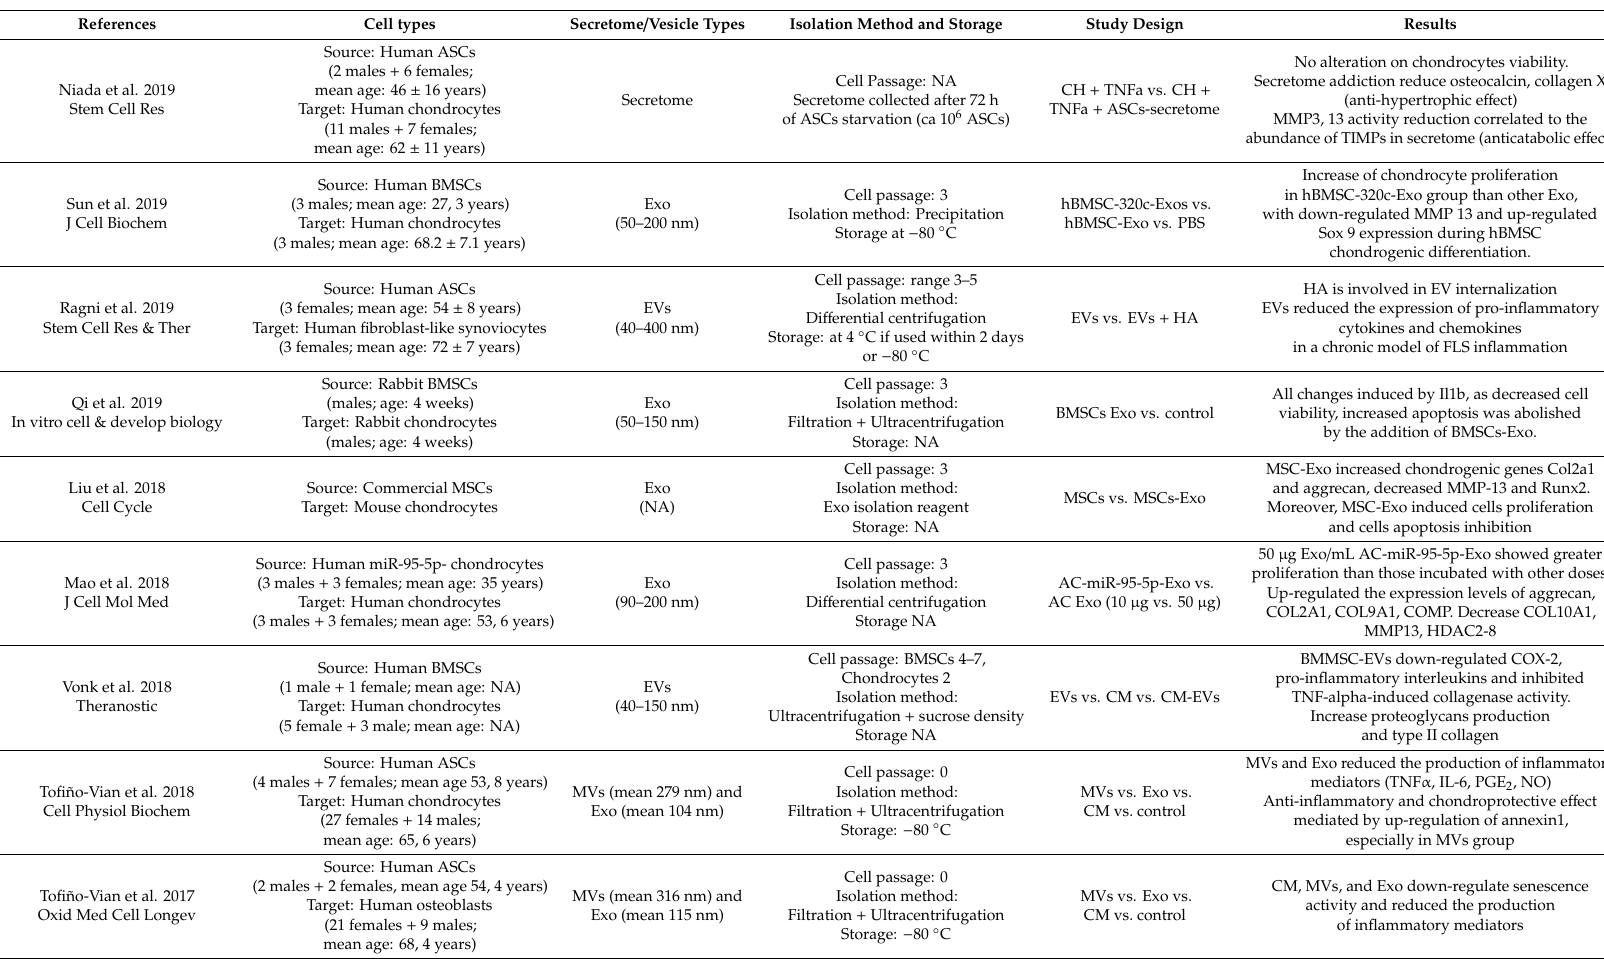
Table 1. Details of papers with in vitro experiments. Abbreviations: hBMSCs, human bone marrow-derived mesenchymal stem cells; Exo, exosome; EV, extracellular vesicles; HA, hyaluronic acid; ASC, adipose-derived mesenchymal stem cells; MVs, microvesicles; CM, conditioned medium; FLS, fibroblast-like